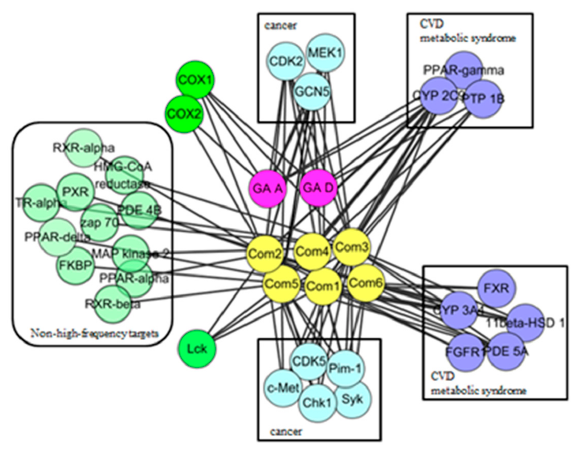
Figure 1. CDK2 SBP model (PDB: 1KE5) and molecular mapping of the Compound 3 . Figure 2. Ingredient ‐ target network of GTs.